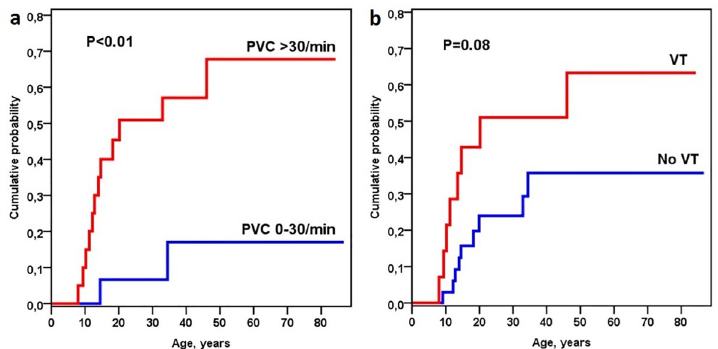
Fig 2. Exercise stress test (EST) findings of each individuals first EST off β -blocker medication (n = 37) and cumulative probability of cardiac events by (a) maximum rate of premature ventricular contractions [PVC], and (b) ventricular tachycardia [VT].